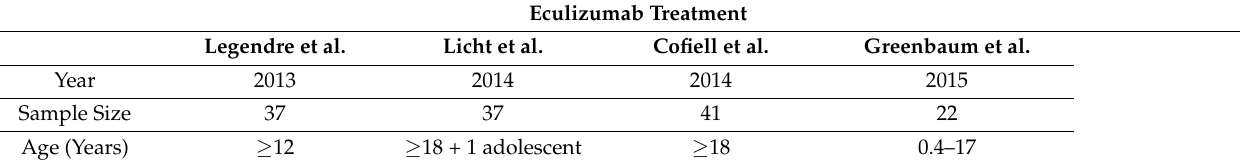
Table 5. Eculizumab treatment trials and resulting outcomes. Eculizumab Treatment